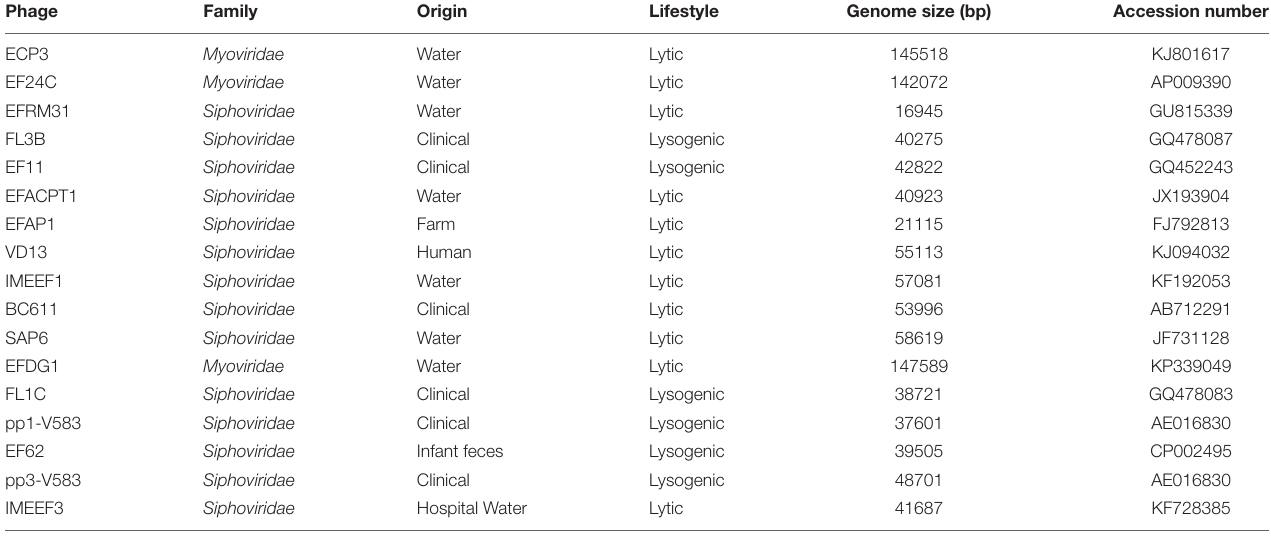
TABLE 2 | Characteristics of the phages subjected to phylogenetic analysis.